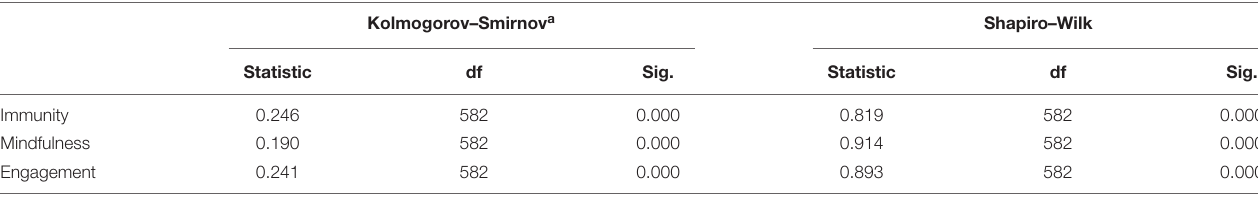
TABLE 3 | Test of normality.